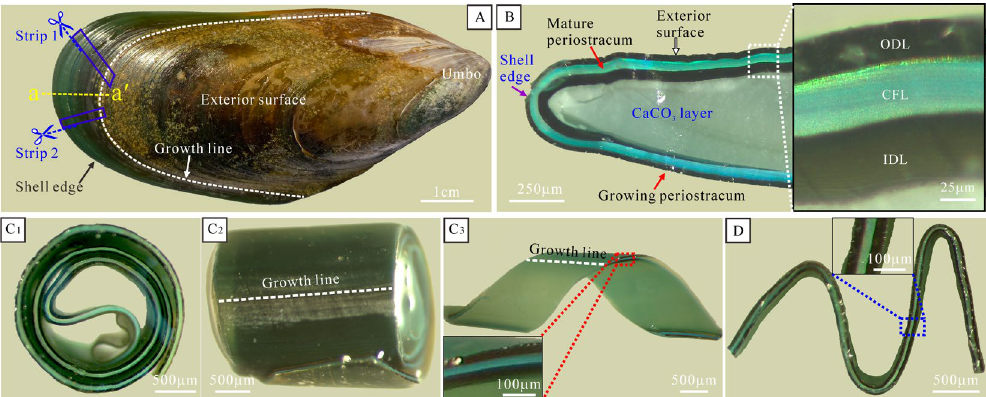
Figure 1. Optical images. ( A ) Exterior view of green mussel shell. ( B ) Cross-section of the shell at direction a-a ′ in ( A ). ( C 1 – C 2 ) Concentric spiral, ( C 1 ) cross-section view, ( C 2 ) top view, ( C 3 ) helicoid spiral. ( D ) Manually deformed letter. ODL: Outer dense layer, CFL: Central fibrous layer, IDL: Inner dense layer.